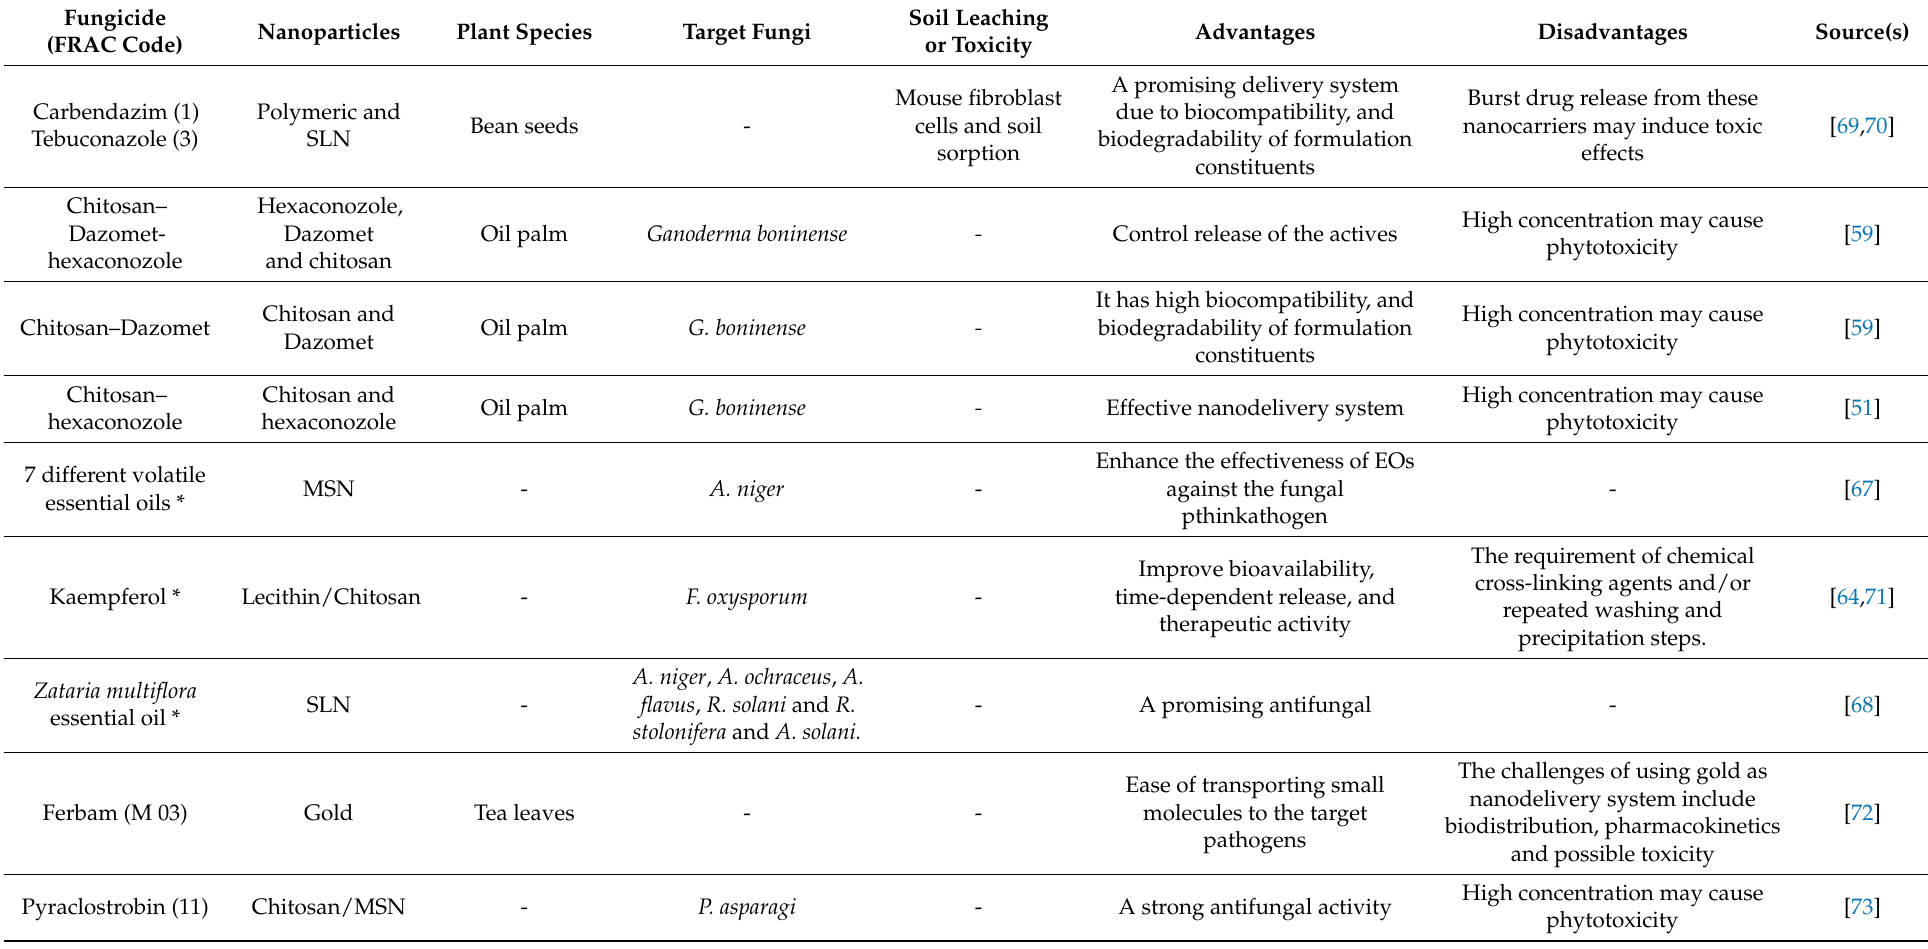
Table 2. Summary of investigations using nanoparticles as actives targeting fungi and carriers of different